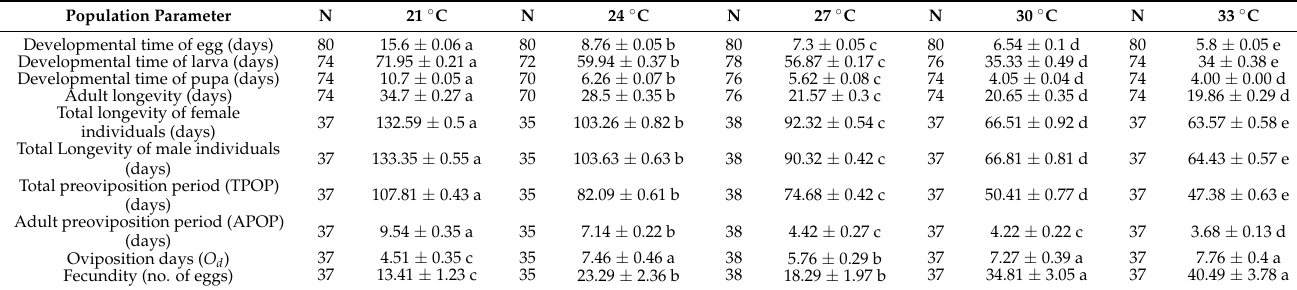
A paired bootstrap test was used to detect a significant difference in developmental time and reproduction parameters of L. serricorne at five different temperatures. Means within a row followed by the same letter are not significantly different. Standard errors were estimated by resampling (100,000 bootstrap samples).